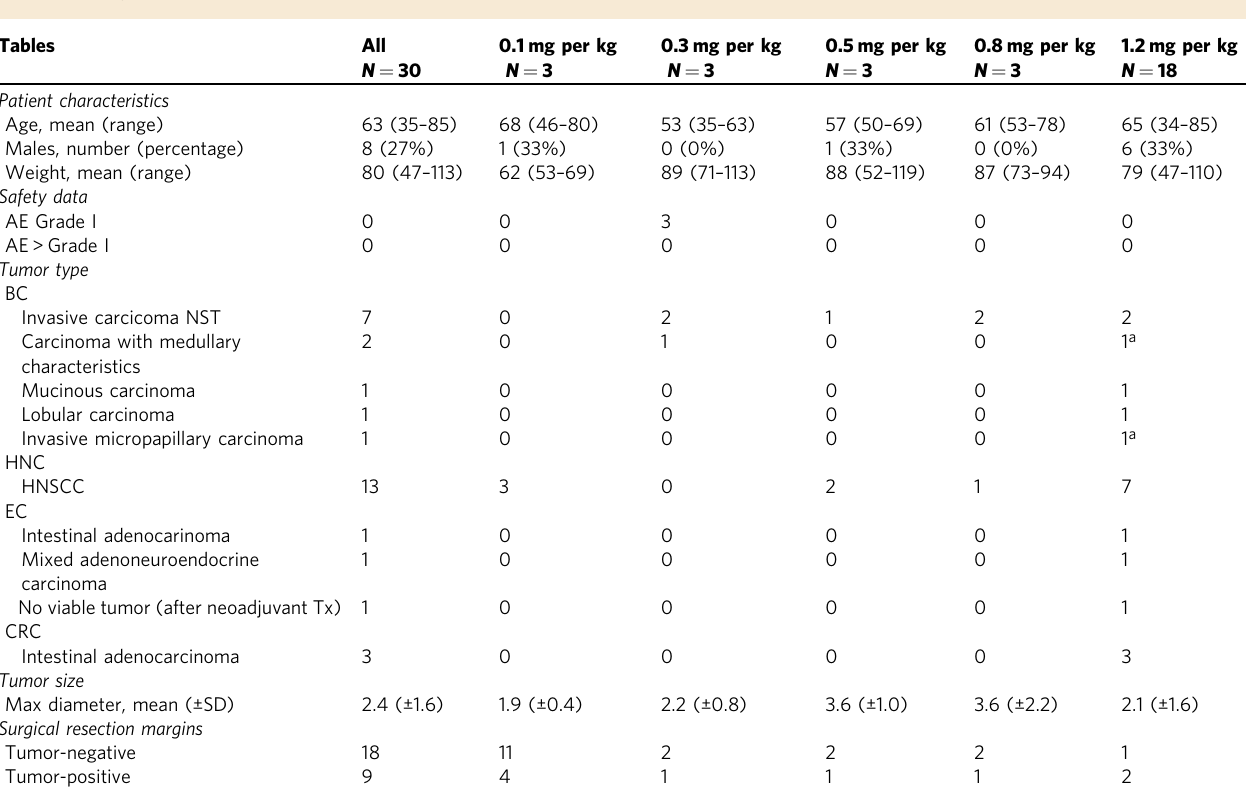
Fig. 2 Study design. Intravenous administration of ONM-100 was performed ~24 h (±8 h) prior to surgery. Ten days of safety assessments (laboratory, pharmacokinetics, ECGs) followed, adverse events were monitored up to day 17 ( a ). During surgery, intraoperative images were obtained prior to incision and after excision of the surgical cavity ( b ). Immediately after excision the specimen was imaged for the presence of a positive surgical margin ( c ). Fluorescence images were obtained during all the standard pathology processing phases ( d , e ), and the H/E slices were correlated with the standard histopathology slices ( f – h ). i.v. intravenous, ECG electrocardiogram, H/E hematoxylin eosin, SOC standard of care. Table 1 Study